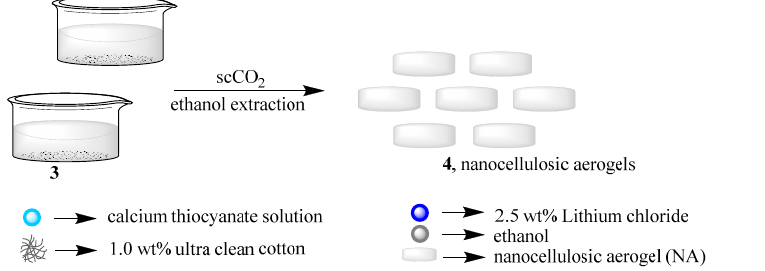
Figure 1. Schematic representation of the preparation of cellulose II aerogels.